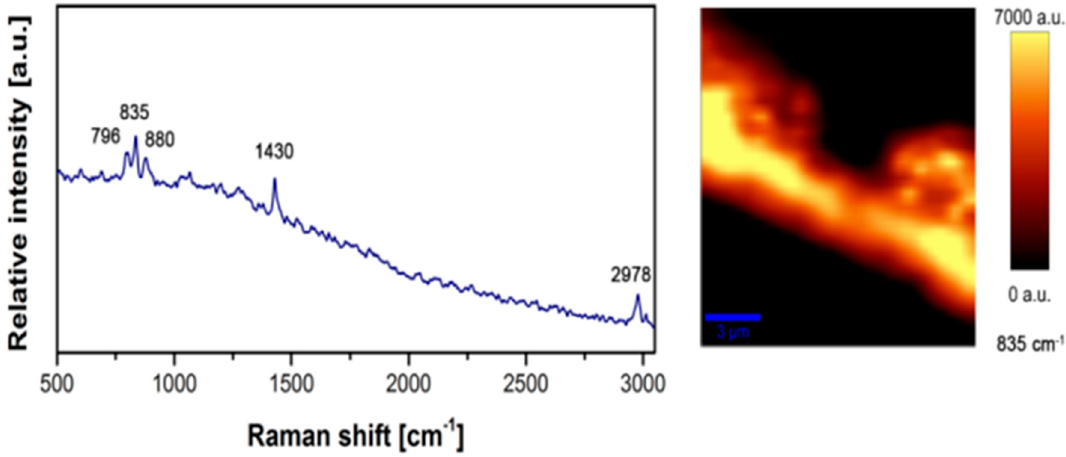
Figure 3. Structural properties of the nano fibers are investigated using Raman spectroscopy. The main peaks on the plot revealed a high concentration of β -phase and therefore denote a high piezoelectricity of the nanofibers [13].